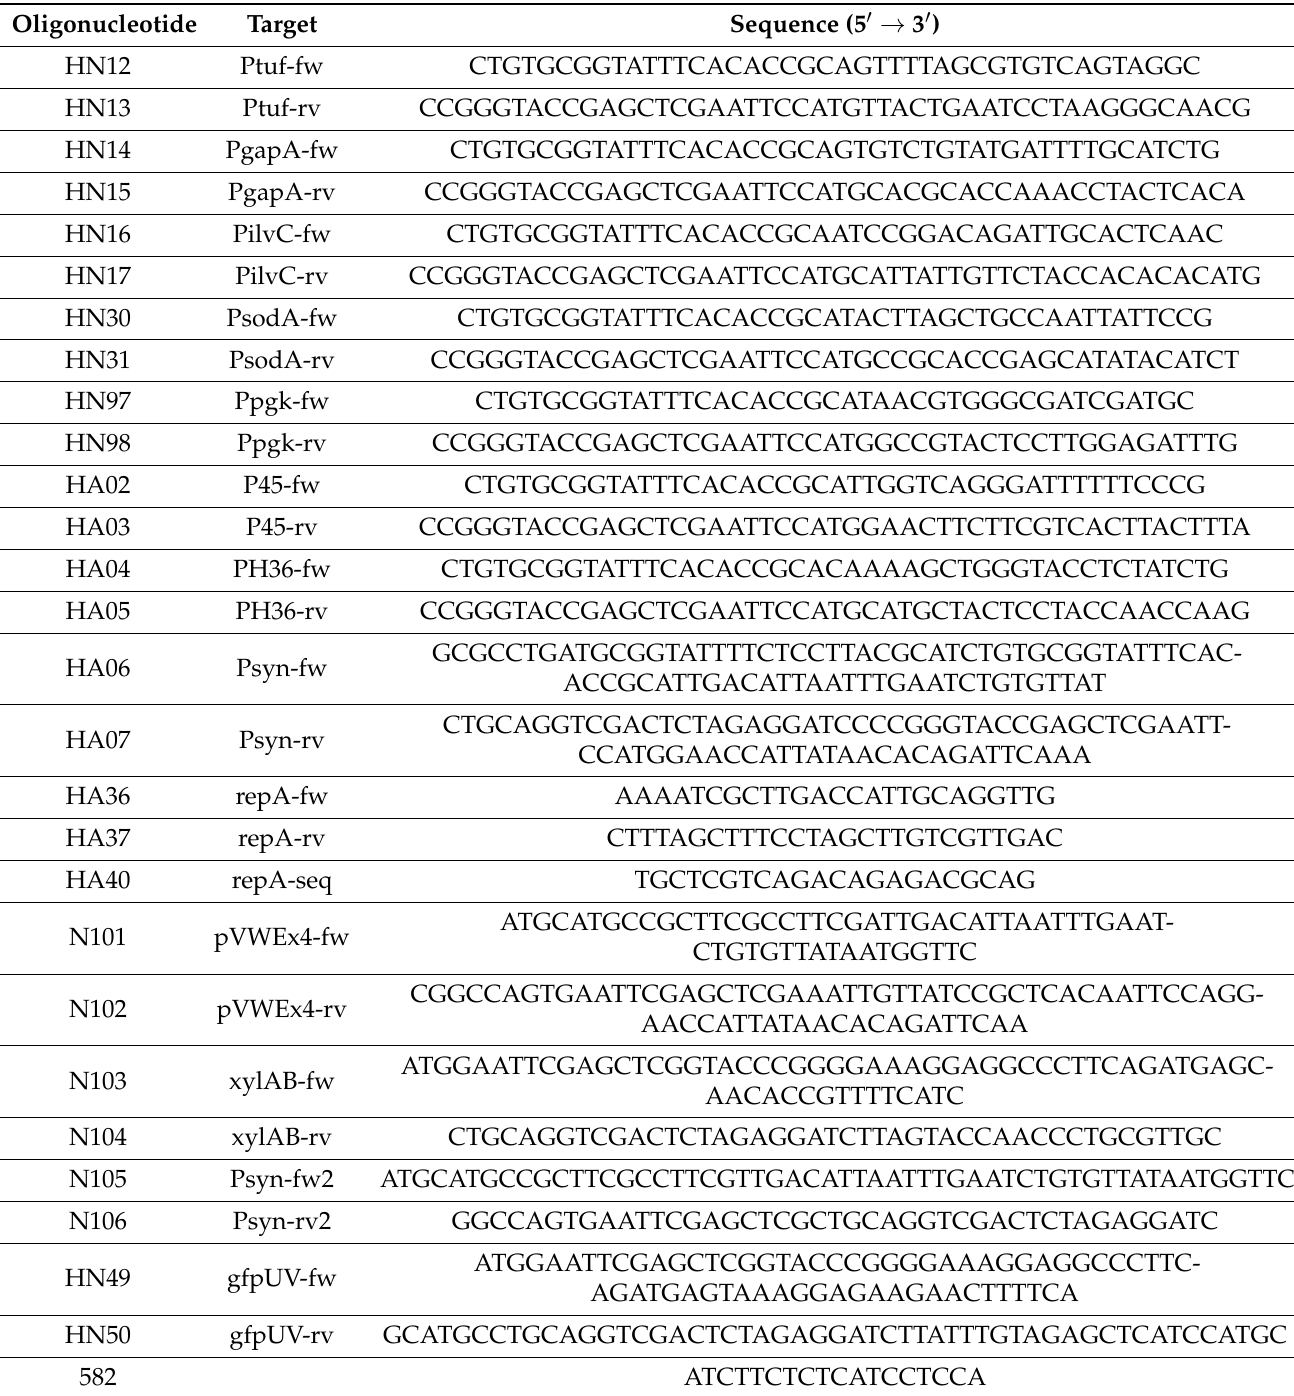
Table 2. Oligonucleotides used in this